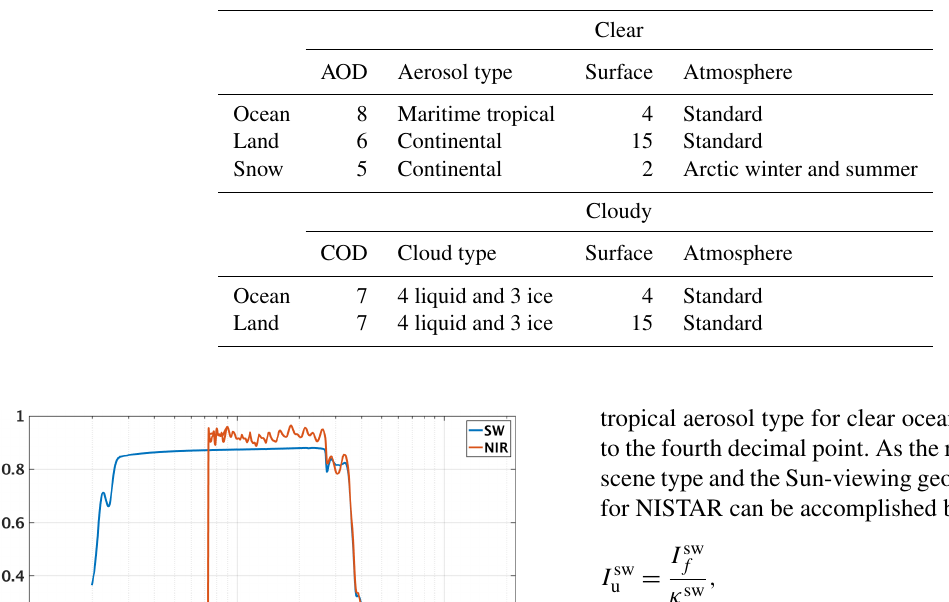
Table 1. Summary of the cases included in the spectral radiance database. AOD is for aerosol optical depth, and COD is for cloud optical depth.